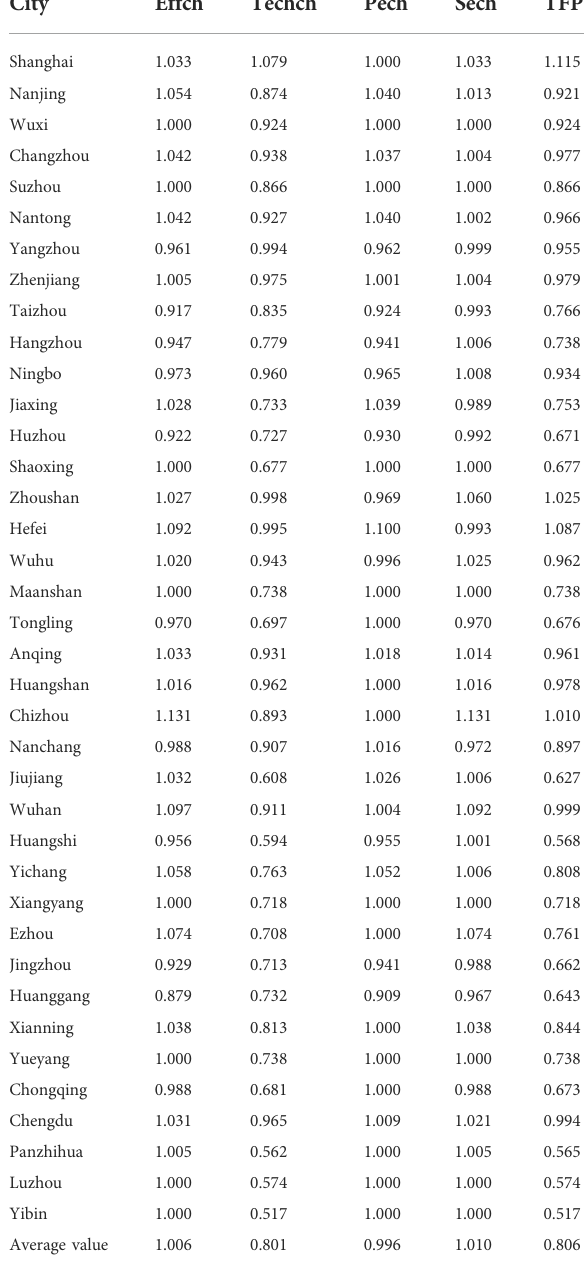
TABLE 3 TFP index and its